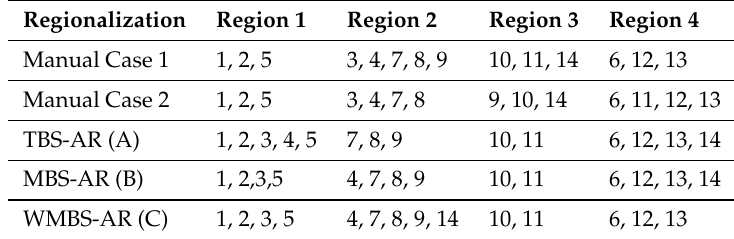
Table 1. Regionalization